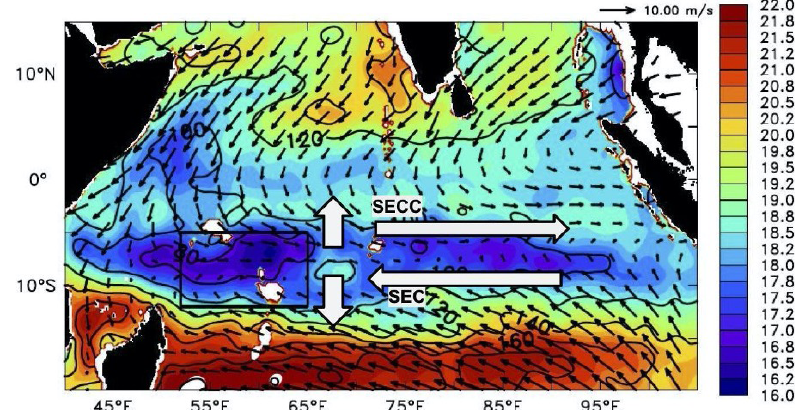
Figure 25. Climatological (Locarnini, 2018) temperature (shading with scale shown to the right) averaged over 0–300m for the months of January and February (shaded) overlaid with wind vectors (ms − 1 ) from QuikSCAT climatology (2000–2008) and the thermocline (depth of 20 ◦ C isotherm, m) depth as the black contour lines. The reference vector for winds is given at the top right corner. The black box represents the Seychelles–Chagos Thermocline Ridge (SCTR). The surface flow indicated by upward- and downward-pointing white arrows promotes upwelling leading to the formation of the SCTR. The white arrow pointing left is the South Equatorial Current (SEC), and the one pointing right is the South Equatorial Countercurrent (SECC). Redrawn after Vialard et al.